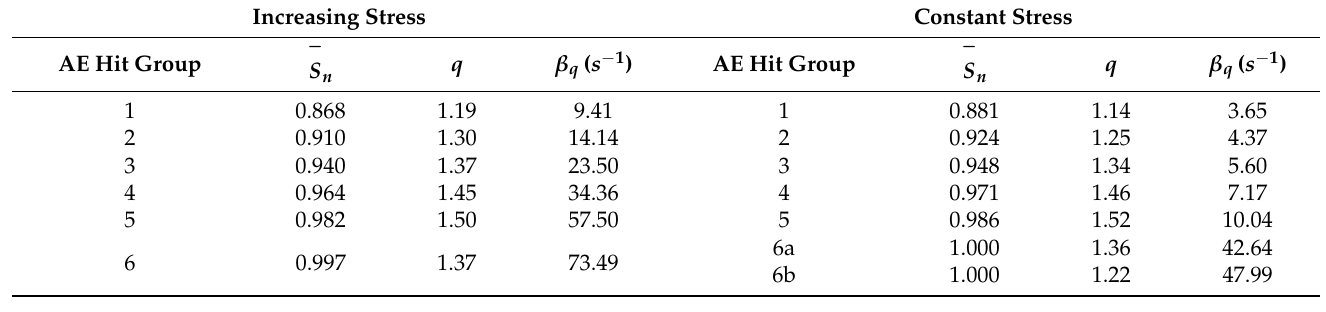
Table 2. The entropic and mechanical parameters during the UCSS experiment for each consequent AE hit group.